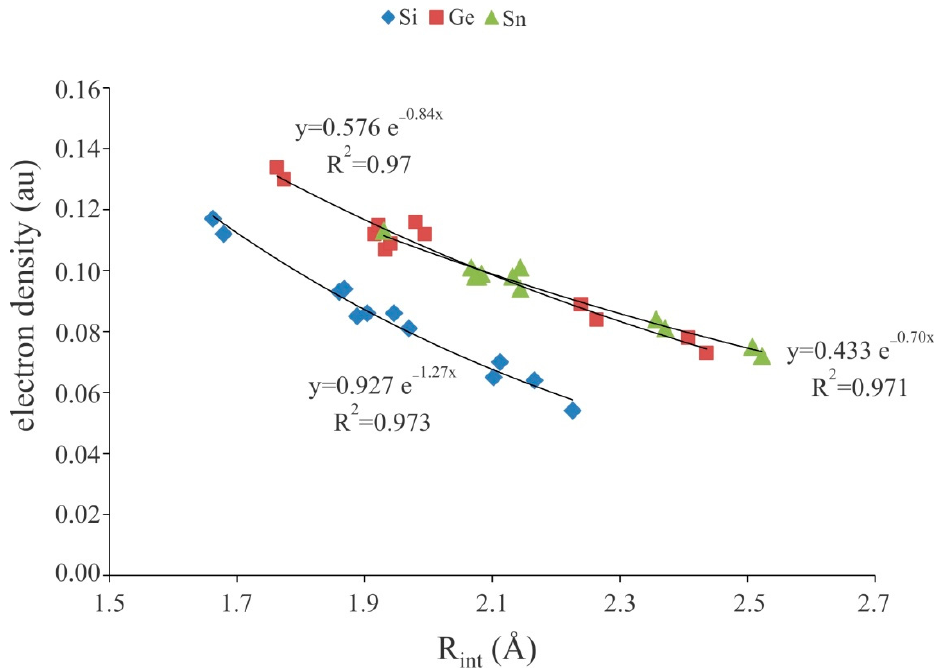
Figure 3. Exponential relationship between theM···A − binding distances and electron density at the corresponding BCPs of the XF 3 M:A − complexes.